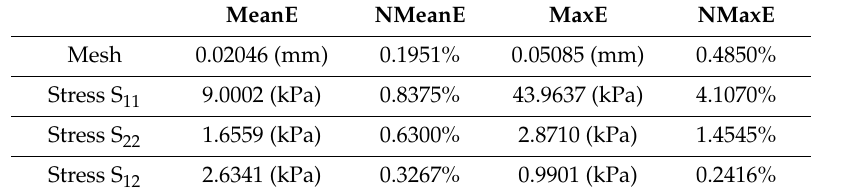
Table 4. Performance measures of the ML model tested on a TAV design shown in Figure 7.